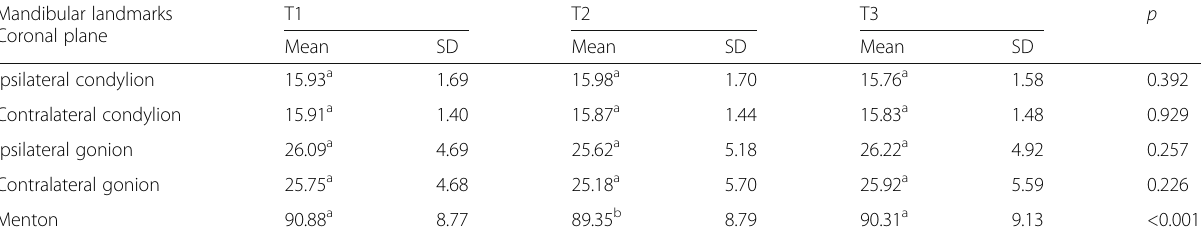
Different superscript letters show statistically significant differences T1 preoperatively, T2 immediately after expansion, T3 6 months after expansion, SD standard